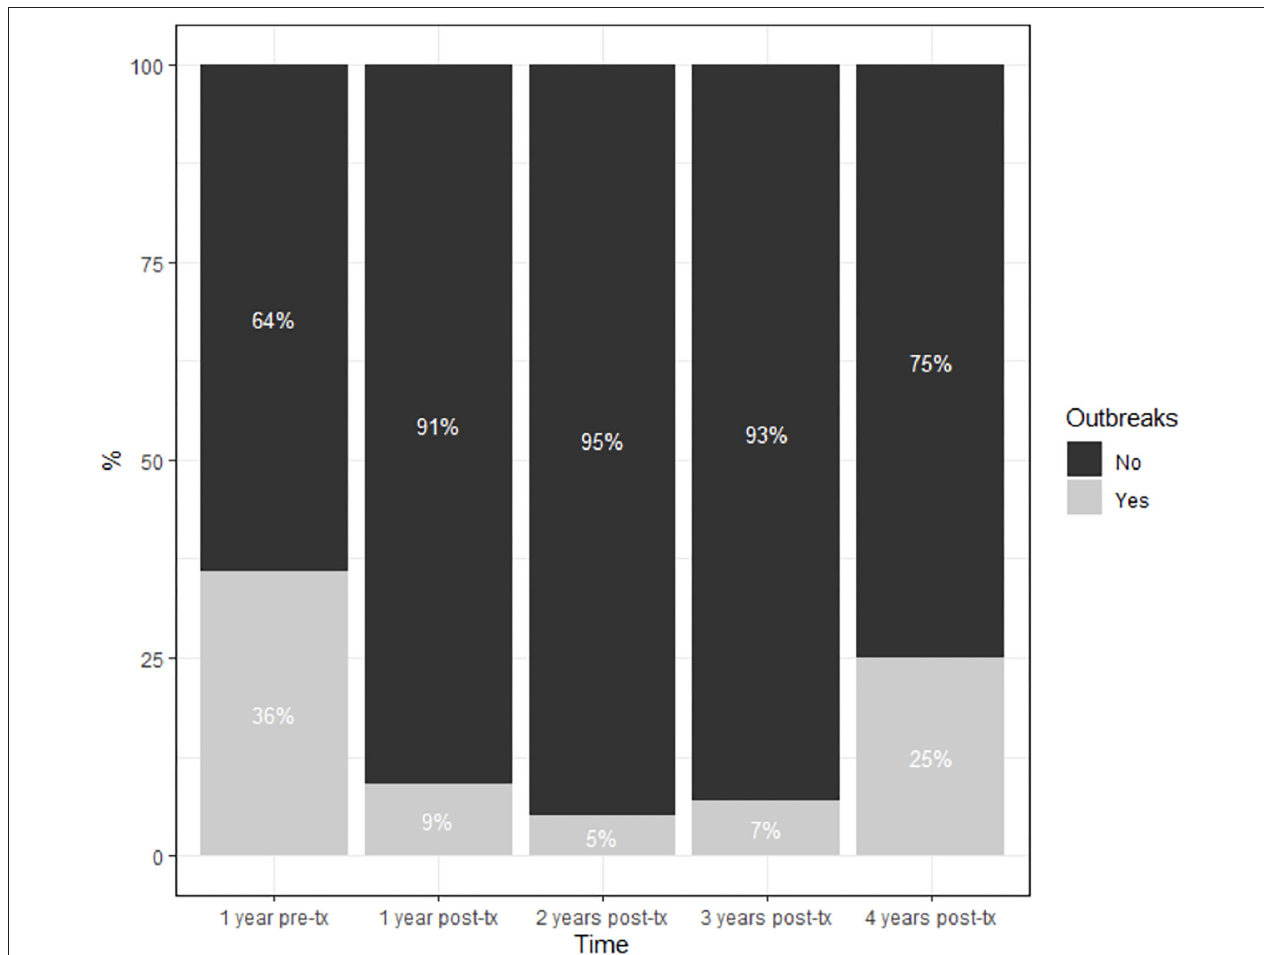
FIGURE 2 | Evolution of patients free of relapses after the start of treatment with